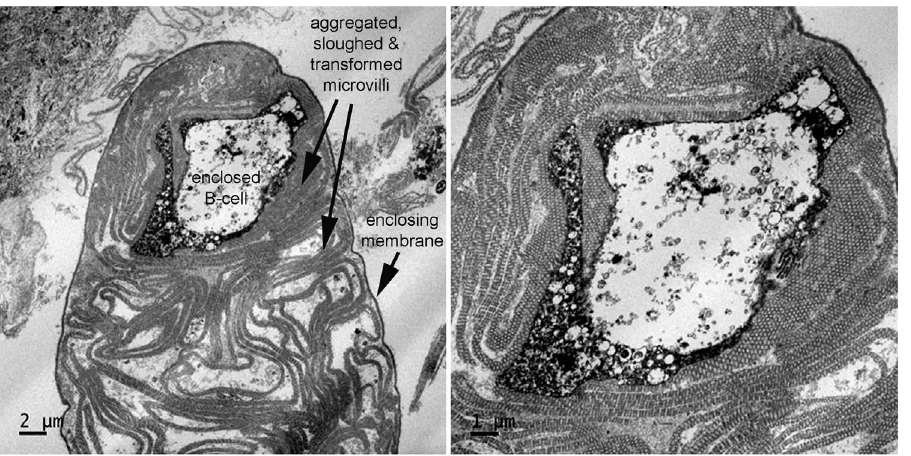
Figure 6. TEM of an ATM structure containing an enclosed, sloughed and modified B-cell. Note the single-layer enclosing membrane and the internal complex of sloughed, modified microvilli.